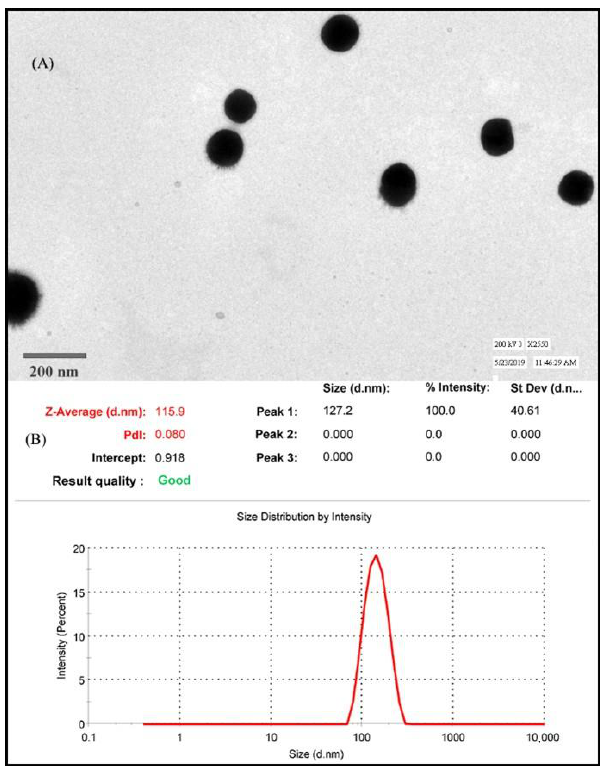
Figure 4. ( A ) HI-RES TEM micrograph of NE. ( B ) Particle size distribution of optimized NE.